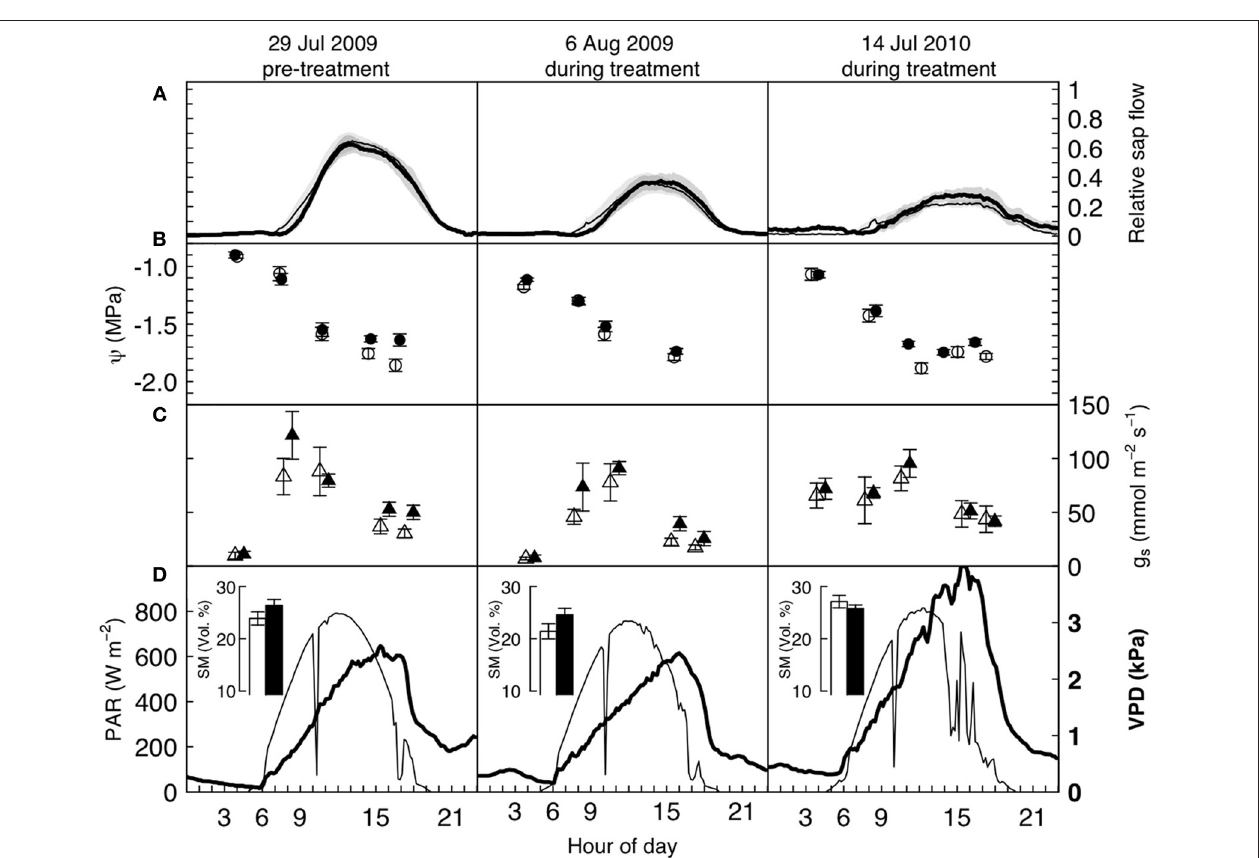
conductance from pre-dawn to dusk, and (D) the photosynthetically active radiation (above the canopy, thin line, left hand side axis) and vapor pressure deficit (at canopy height, bold line, and font, right hand side axis). Shaded areas and bars represent one standard error. None of the differences between control and treated trees is significant on any of the 3 days (see